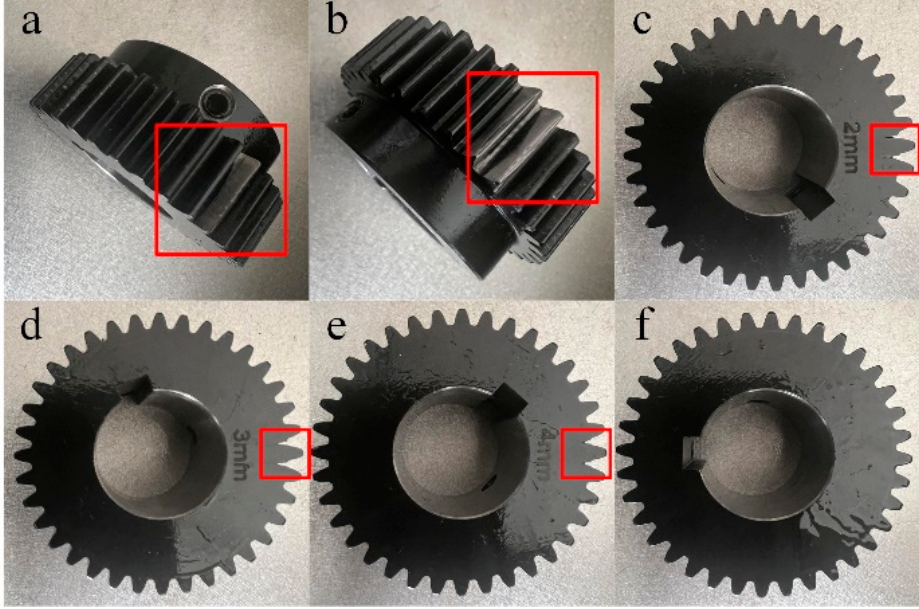
Figure 8. Gears with different failure modes. ( a ) 1-tooth worn. ( b ) 2-tooth worn. ( c ) 2 mm crack. ( d ) 3 mm crack. ( e ) 4 mm crack. ( f ) Healthy. ( d ) 3 mm crack. ( e ) 4 mm crack. ( f ) Table 3. Details of the gear datasets.